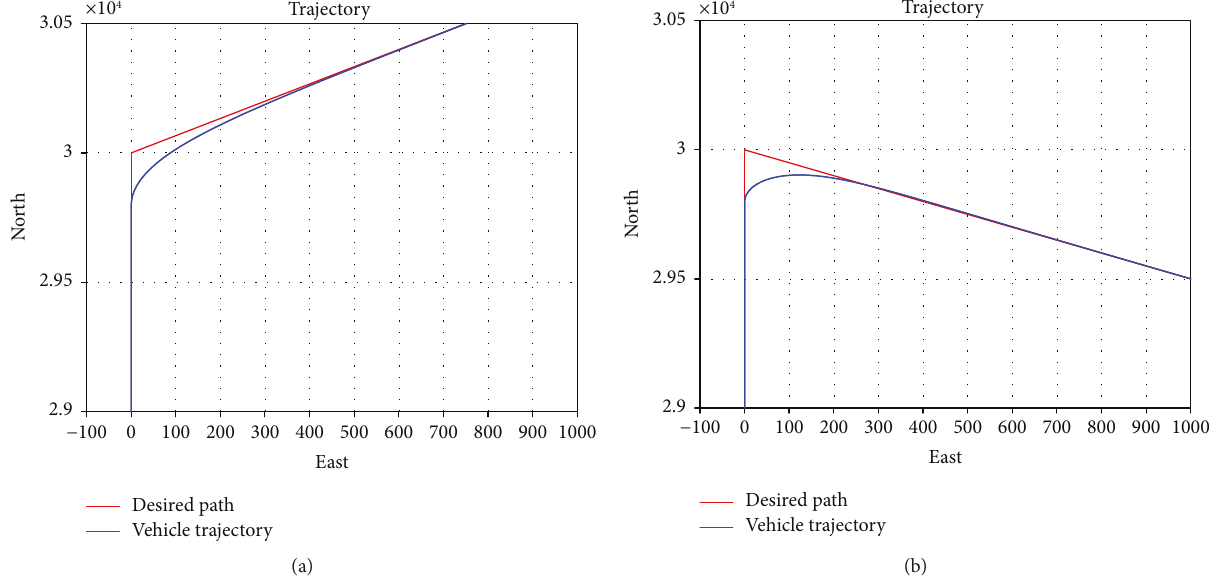
Figure 10: Path transition between straight-line segments. (a) Obtuse angle, (b) acute angle.